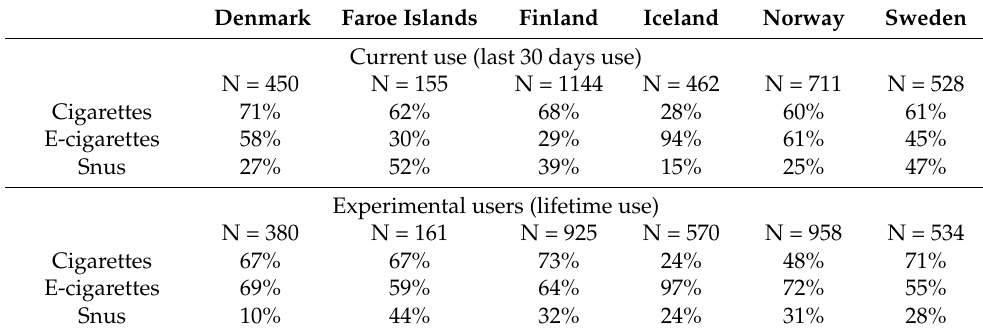
Table 1. Proportions of cigarette, e-cigarette, and snus users among experimental and current users, by country.